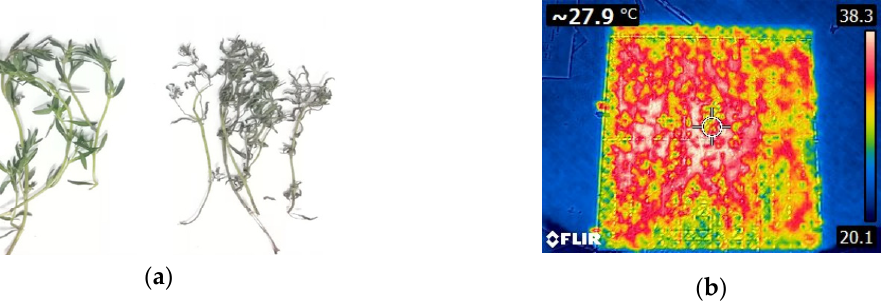
Figure 2. Drying process of fresh Oregano: ( a ) Oregano leaves before ( left ) and after ( right ) of drying process, ( b ) thermography for final product at 1380 kPa.